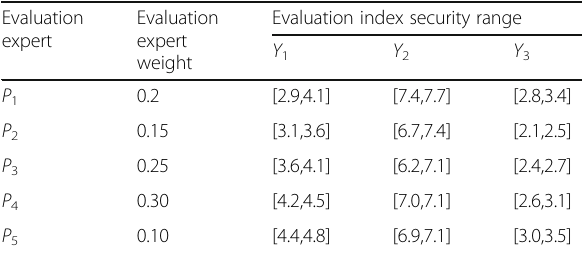
Table 6 Evaluation index security